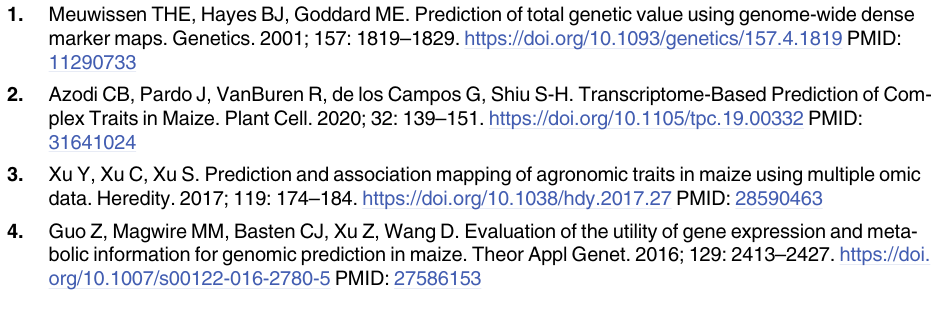
S2 Table. Prediction accuracy of 26 complex traits in NAM using HARE from 7 diverse tis- sues: germinating seedlings root (GRoot), germinating seedlings shoot (GShoot), 2 cm from the base of leaf 3 (L3Base), 2 cm from the tip of leaf 3 (L3Tip), mature mid-leaf tissue sampled during mid-day (LMAD), mature mid-leaf tissue sampled during mid-night (LMAN), and developing kernels harvested after 350 growing degree days after pollination (Kern), mean, and maximum expression of genes across all tissues. P value (high) and P value (low) were calculated using a Monte Carlo procedure to test if the accuracy using HARE was significantly higher or lower than random HARE. Models were trained in Goodman Asso- ciation panel and tested in